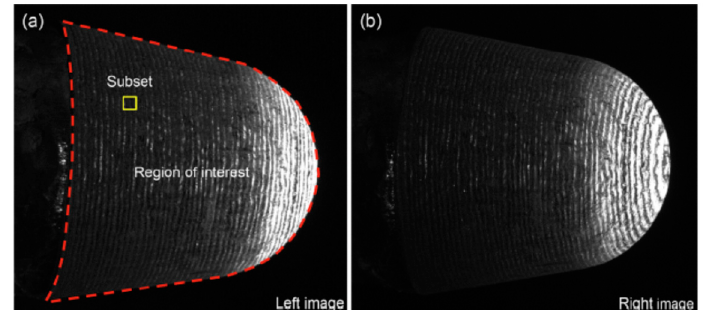
Figure 5. Example of UV illuminated images captured by Dong and Pan [66] at 1000 ◦ C: ( a ) this is the image captured by the left camera at 1000 ◦ C, showing the region of interest and the subset used by the DIC software; ( b ) this is the image captured by the right camera at 1000 ◦ C. Reproduced from Dong and Pan [66], with permission from Elsevier.